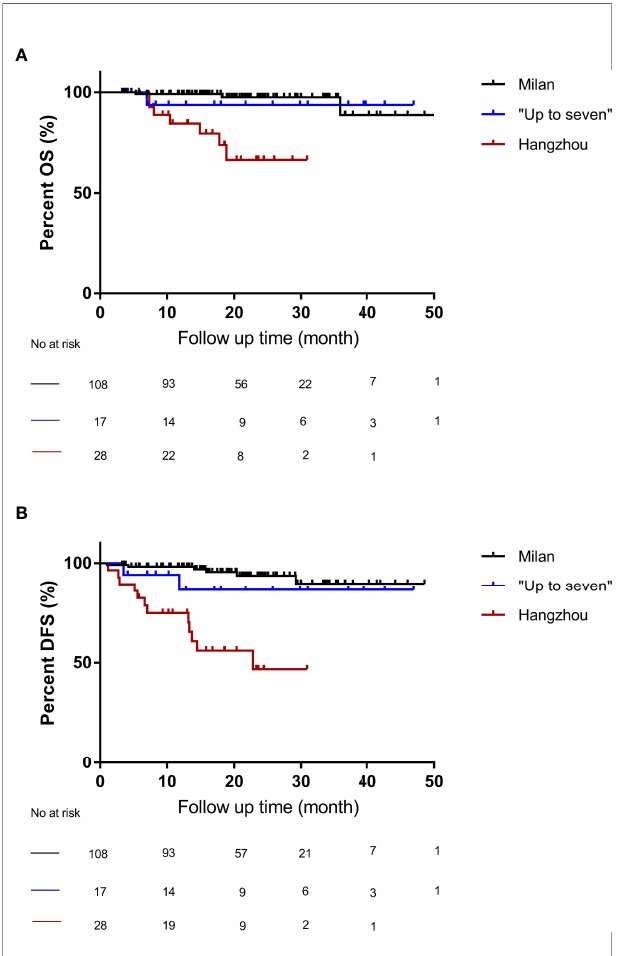
FIGURE 2 | The OS and DFS of patients under different liver transplant criteria. (A) compared with the Milan criteria, patients who did not meet the Milan criteria but met the “ Up-to-seven criteria ” had no signi fi cant difference in OS ( p = 0.69), while patients who did not meet the “ Up-to-seven ” but met the Hangzhou criteria had signi fi cant differences ( p < 0.001). (B) compared with the Milan criteria, patients who did not meet the Milan criteria but met the “ Up-to-seven criteria ” had no signi fi cant difference in DFS ( p = 0.35), while patients who did not meet the “ Up-to-seven ” but met the Hangzhou criteria had signi fi cant differences in DFS ( p < 0.001). OS, Overall survival; DFS, disease-free survival; HCC, hepatocellular carcinoma.